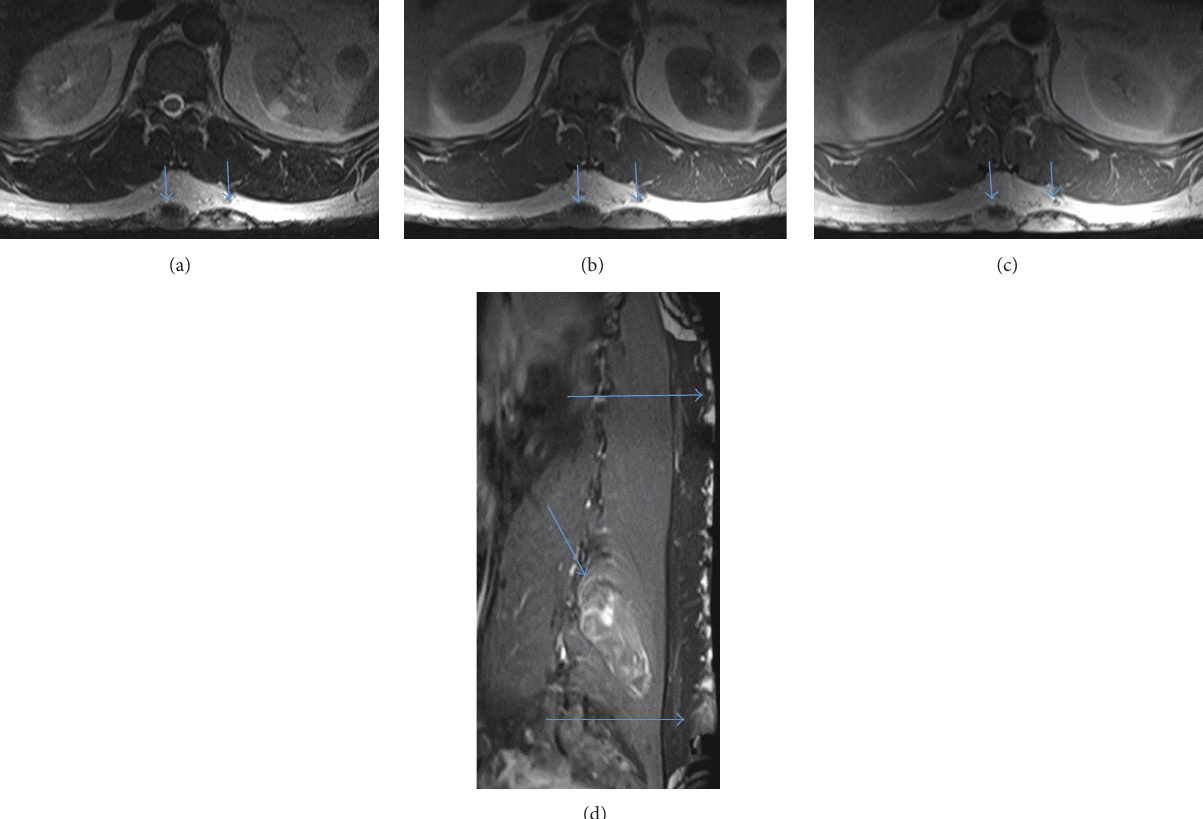
disturbance (53%), and faint-to-mild motor weakness